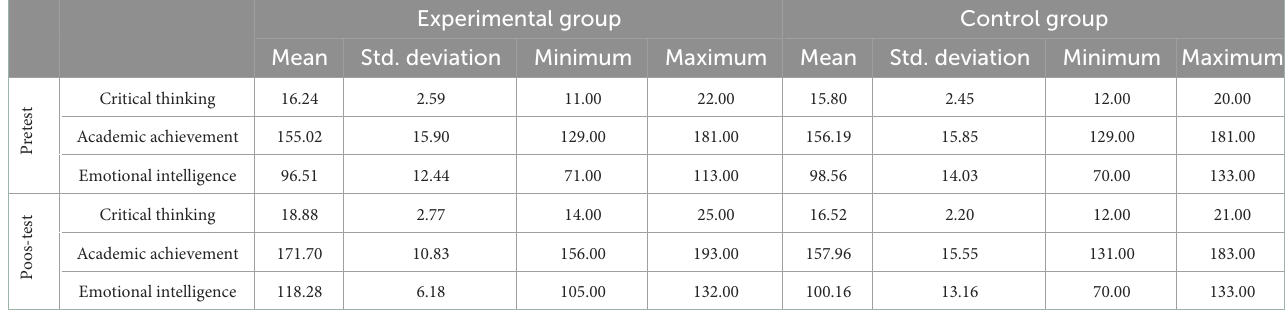
TABLE 1 Central indices and posttest dispersion in control and experimental groups.